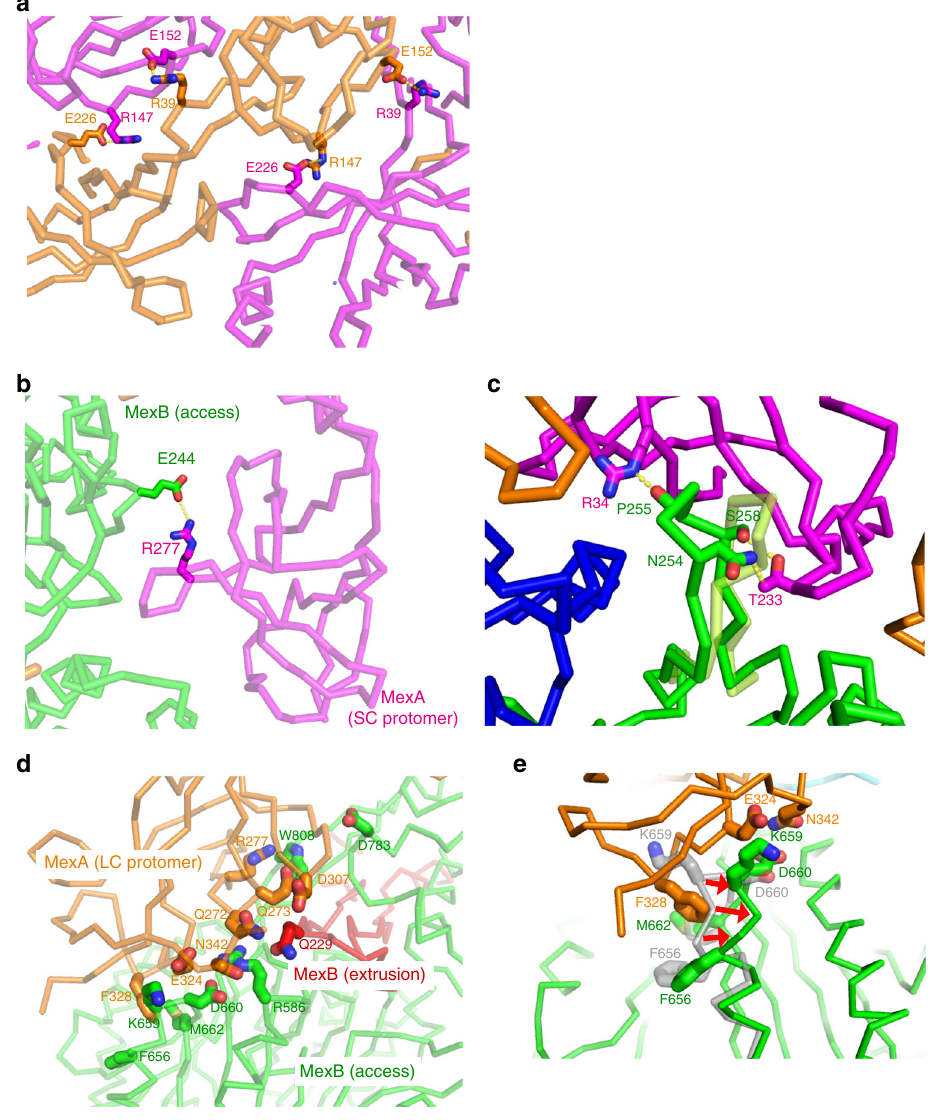
Fig. 3 Detailed views of the MexA – MexA and MexA – MexB interactions. a Detailed view of the lipoyl domains of MexA [shown in magenta (SC protomer) or orange (LC protomer)]. Side chain atoms of residue pairs identi fi ed in our model of complex formation are shown as stick models. b Close-up view of the interaction between the FL domain in MexB (green) and the SC protomer (magenta). The key loop in the crystal structure (PDB ID: 3w9i) is shown in transparent lemon. Side chain atoms of critical residues identi fi ed in the complex formation experiment are shown as stick models. c Interaction between the porter domain of MexB (green) and the SC protomer (magenta). d , e Interaction between the PC1 domain (green) and LC protomer (orange) viewed from the side of PC1 ( d ) or top of PC1 ( e ). The adjacent MexB protomer is shown in red. The shifted helix from the crystal structure of MexB in the Access state is shown in gray. Red arrows show a movement of shifted